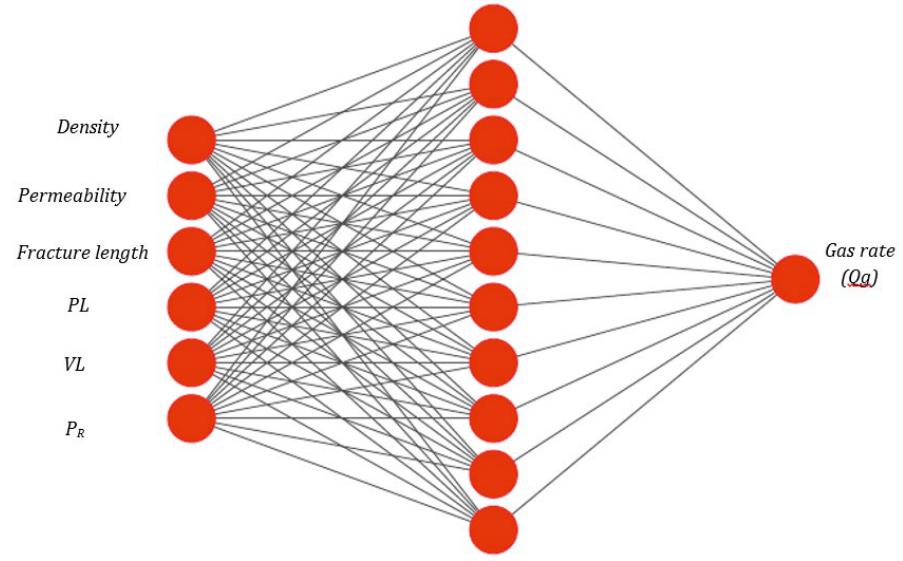
Figure 13. Artificial neural network architecture used in this study.